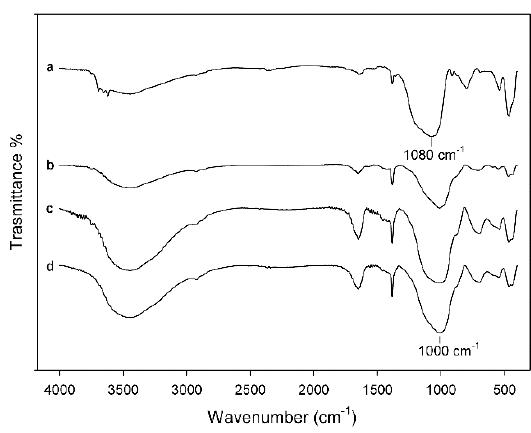
Figure 2. (a) MK FTIR spectrum compared with FTIR spectra of GP3 after (b) 7 days (c) 14 days and (d) 28 days.